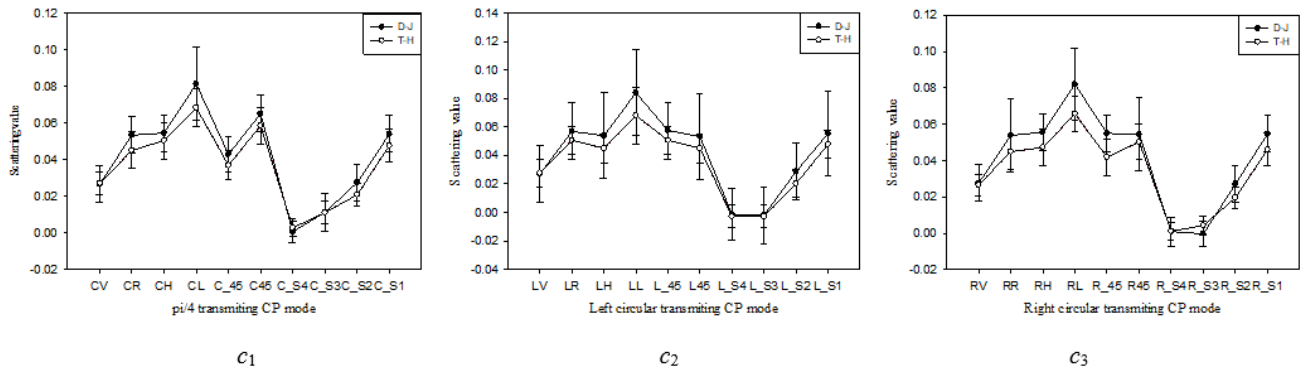
Figure 6. The CP parameters line diagram of the two types of rice under three transmitting modes